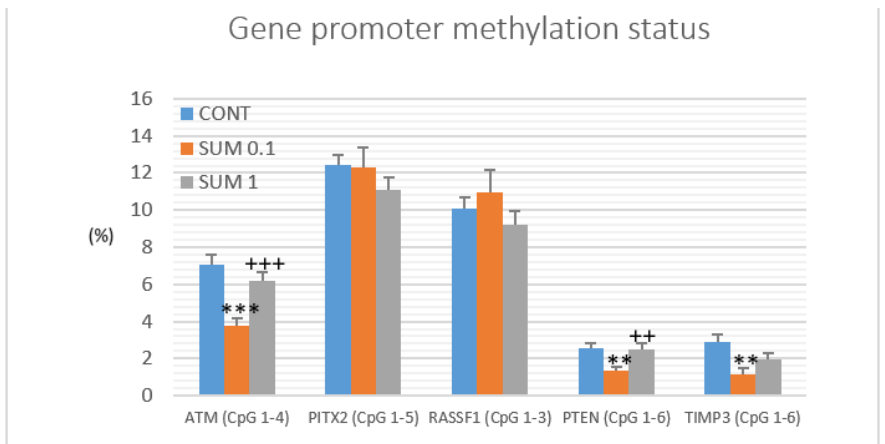
Figure 8. Promoter methylation status of ATM, PITX2, RASSF1A, PTEN, and TIMP3 genes in mammary carcinoma specimens in rats. Methylation status was appointed from all analyzed CpG isles of mentioned gene promoters (the number of analyzed isles is shown in the brackets). Significant differences, ** p < 0.01, *** p < 0.001 vs. CONT group and ++ p < 0.01, +++ p < 0.001 vs. SUM 0.1 group.